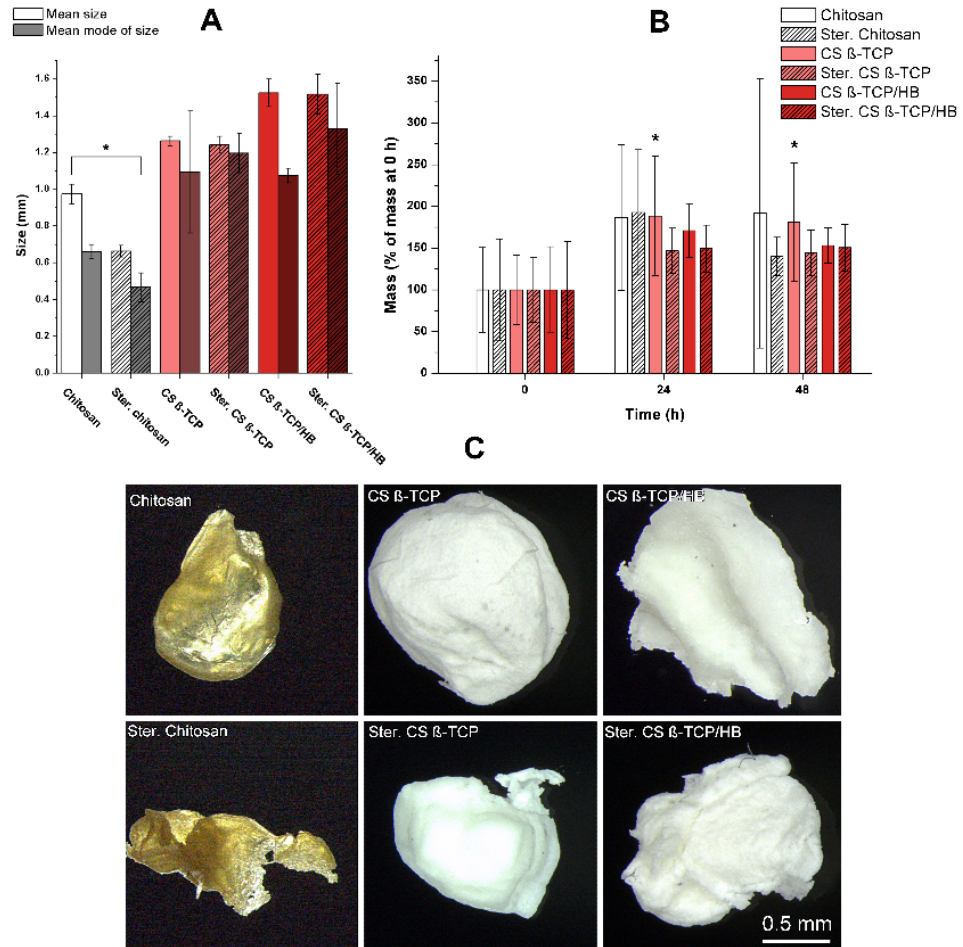
Figure 3. ( A )—parameters of prepared materials (mean size, mean mode of size). The size parameter is understood as the cross-section of digitally photographed granules. Error bars represent standard deviations ( n = 3). ( B )—swelling of the materials after 24 and 48 h in 0.1 M PBS in 37 °C. Mean sizes marked with an asterisk (*) are significantly different from each other (one-way ANOVA with post hoc Tukey test, p < 0.05). Error bars represent standard deviations ( n = 12). ( C )—digital photography of materials after 48 h of swelling.